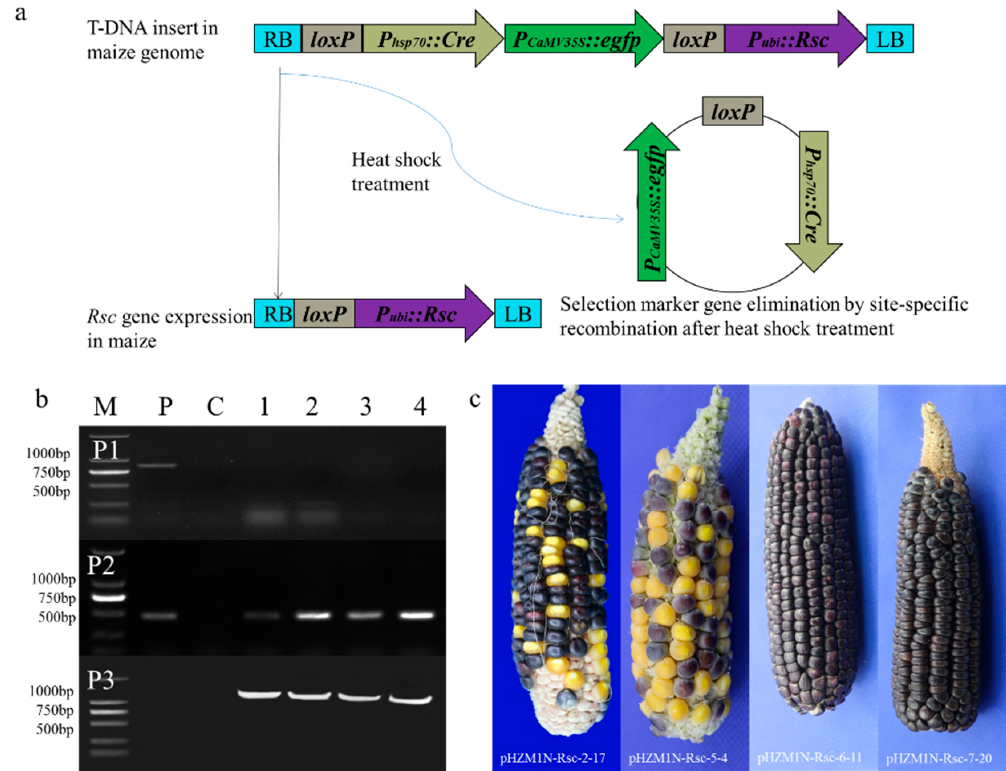
Figure 4. Induction of marker excision and molecular analysis of regenerated plants. ( a ) Design of DNA constructs and molecular strategy of marker-free site-specific gene integration. ( b ) PCR analysis of the transformed maize lines. Specific primer pairs P1, P2, and P3 to detect the selection marker gene egfp , the regulator gene ( Rsc ), and the residual sequence (RS), respectively. M, BM2000 DNA marker; P, positive control P was used as the plasmid DNA; C, negative control; lanes no. 1–4, DNA from independent transgenic transformants plants; ( c ) Rsc gene expression in genetically modified materials in T 1 generation. Wild type ears appeared with yellow and white kernels, while the transformation ears with the Rsc gene expression phenotype showed a lot of purple kernels. Table 2. GFP fluorescence assays and PCR analysis of the auto-excision marker in calli.